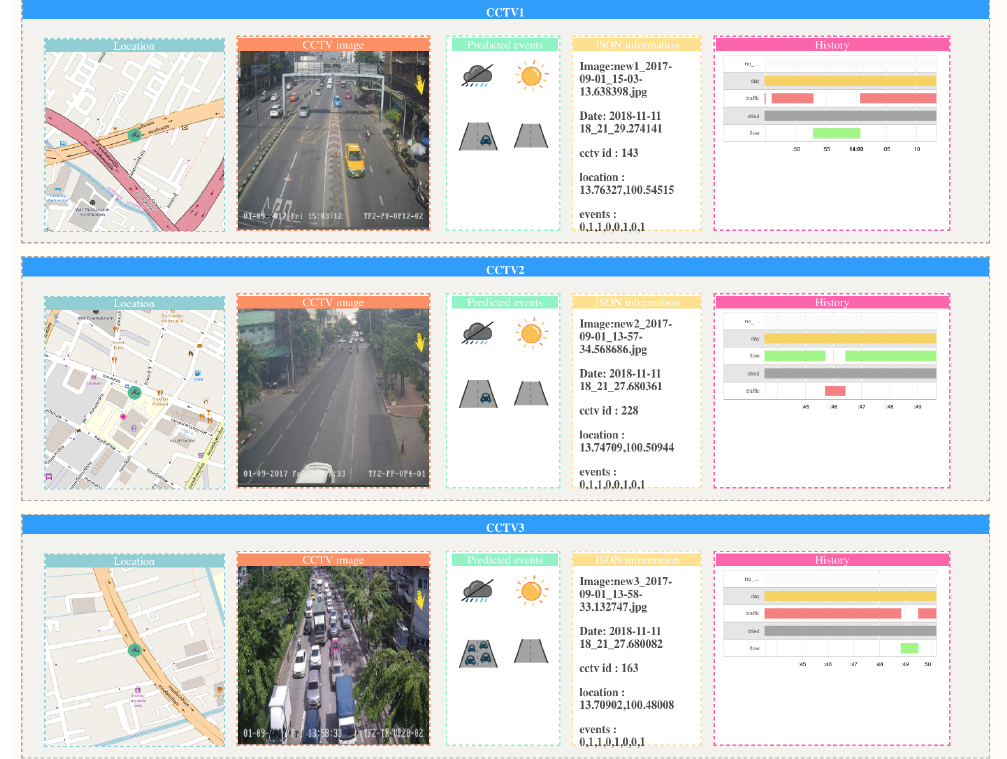
Figure 9. Prototype of the road environment extraction